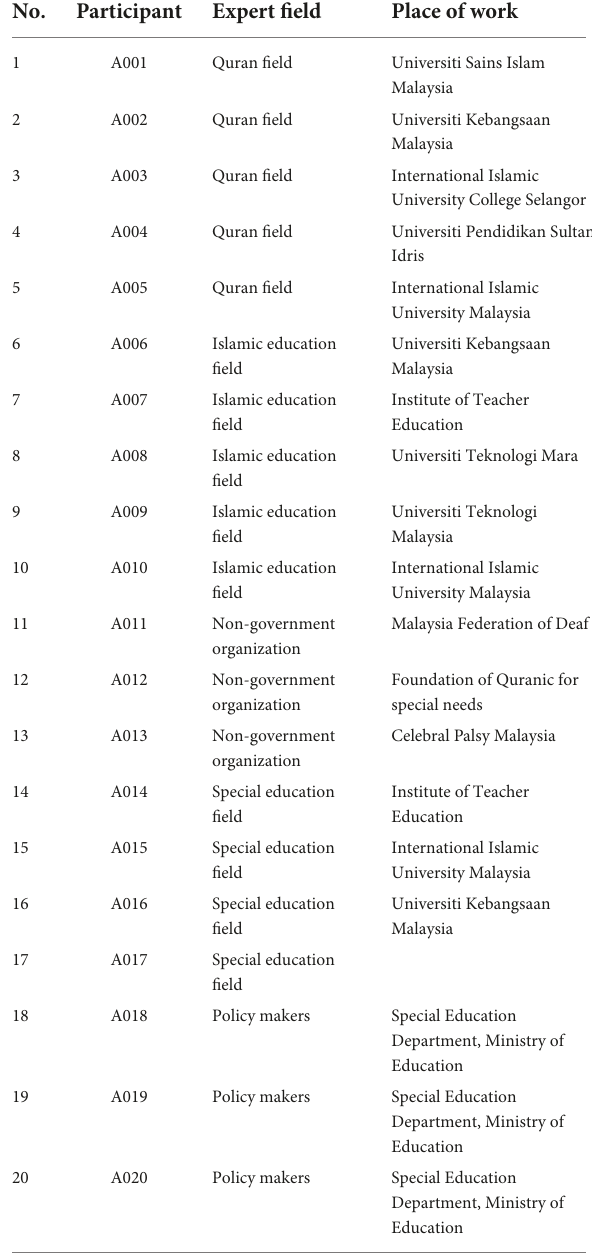
TABLE 1 List of the